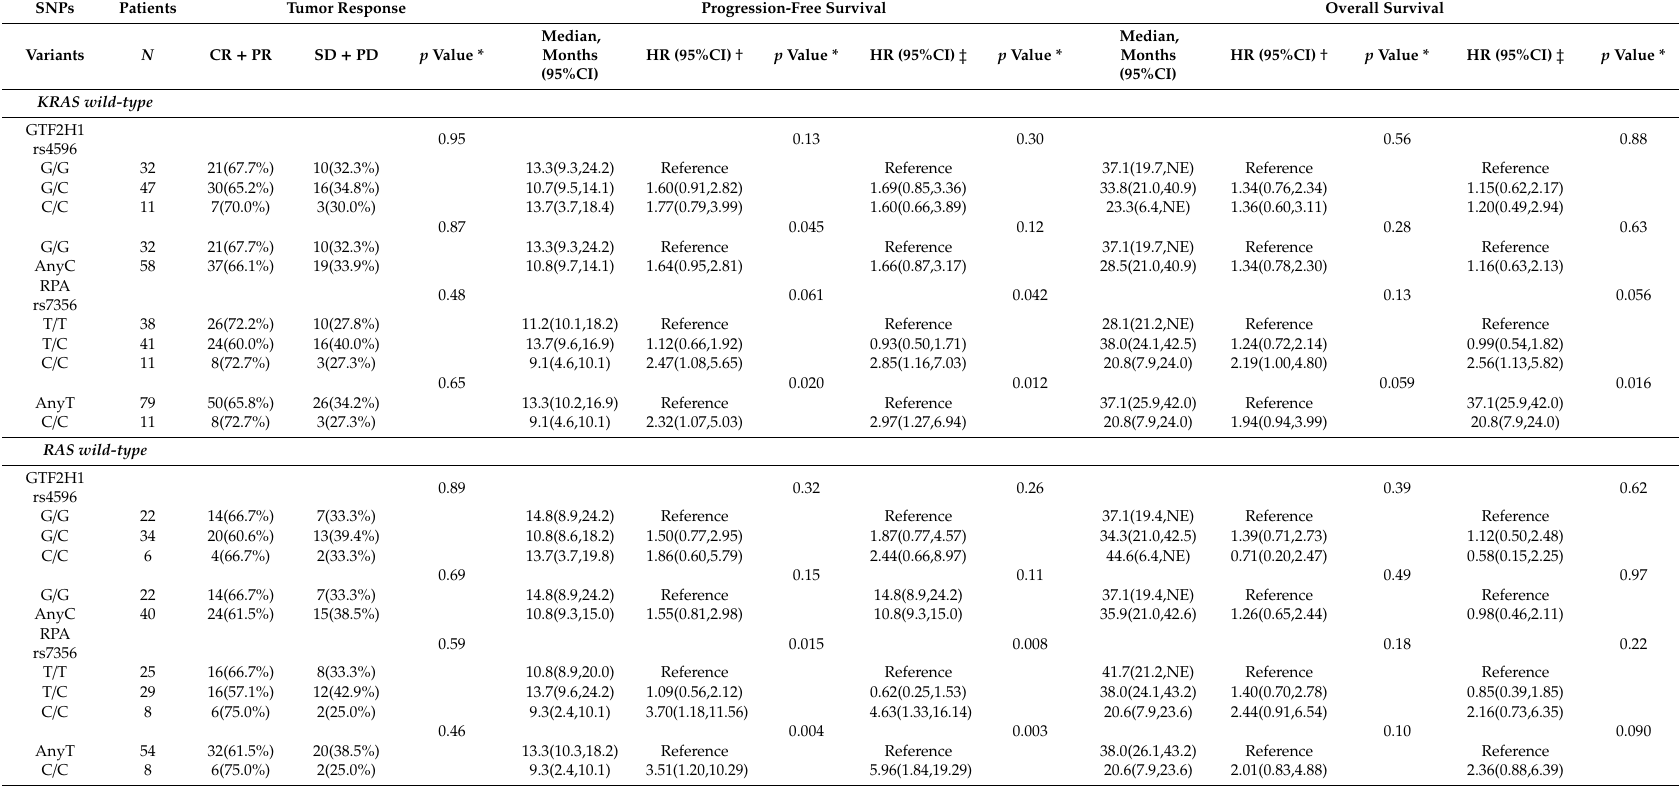
Table 2. Subgroup analysis of KRAS wild-type and RAS wild-type in the discovery